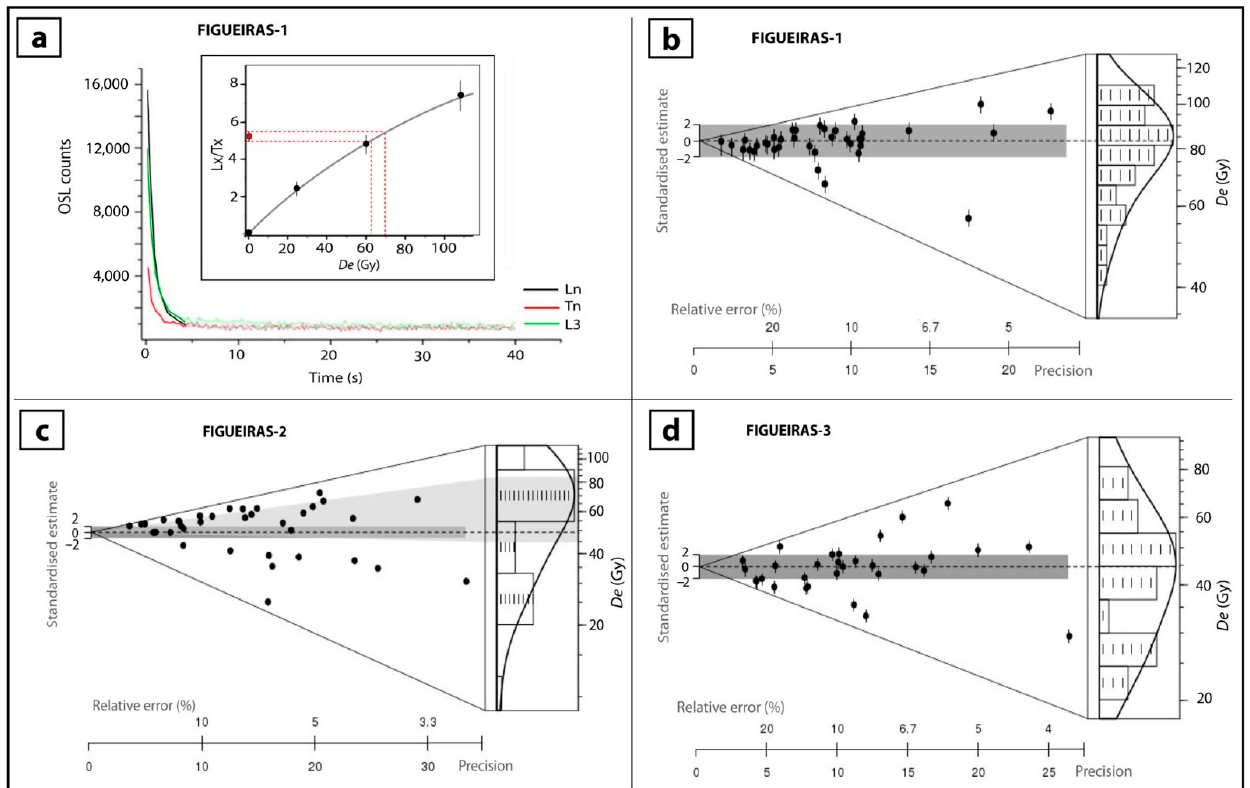
Figure 6. Quartz OSL signal and D e s distribution. ( a ) OSL ‐ signal decay ‐ curve from one aliquot of Figueiras 1 sample. Lines show the intensity (counts per second) from natural OSL ‐ signal (Ln), natural OSL ‐ signal from test ‐ dose (Tn) and OSL ‐ signal from third regenerative cycle from SAR protocol [44]. (Inset) Exp + lineal adjust for OSL growth ‐ curve from normalised OSL ‐ signal from SAR (Lx/Tx) versus equivalent dose ( D e ), including the linear interpolation [58] from natural nor ‐ malised OSL ‐ signal. ( b – d ). Distribution of data from Figueiras 1, 2 and 3 samples, through Abanico plots [61]. Black dots represent D e estimates from accepted single aliquots, showing error bars. Grey bar in the radial plots represents the standard error (±2 σ ) from the standardised estimate (weighted mean) by the Central ‐ Age Model (CAM) (dotted line). Kernel ‐ density estimate plot is also repre ‐ sented. Light ‐ grey area in ( c ) represents the standard error (±2 σ ) from the kernel density estima ‐ tion .